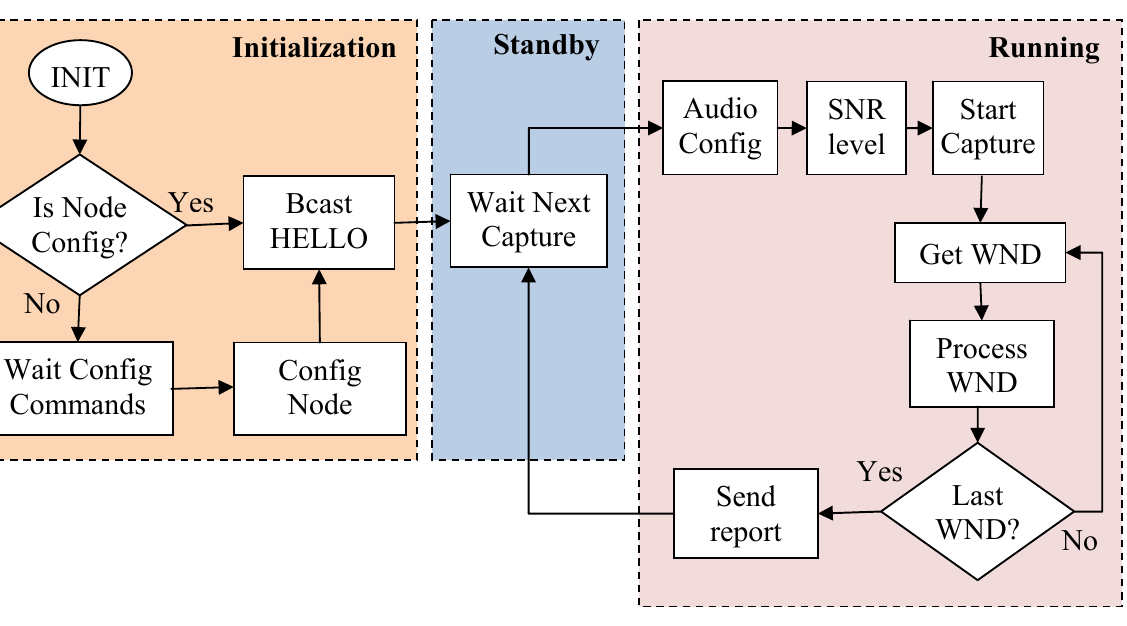
Figure 6. Flow diagram of the bioacoustic sensor operating software, with its three differentiated working modes: Initialization, standby and